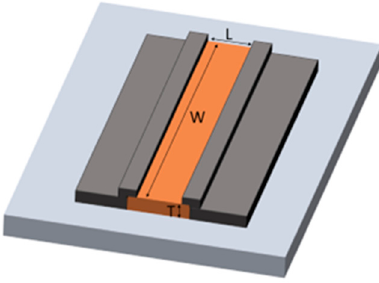
Figure 1. Schematic diagram of the ZGO gas sensor.